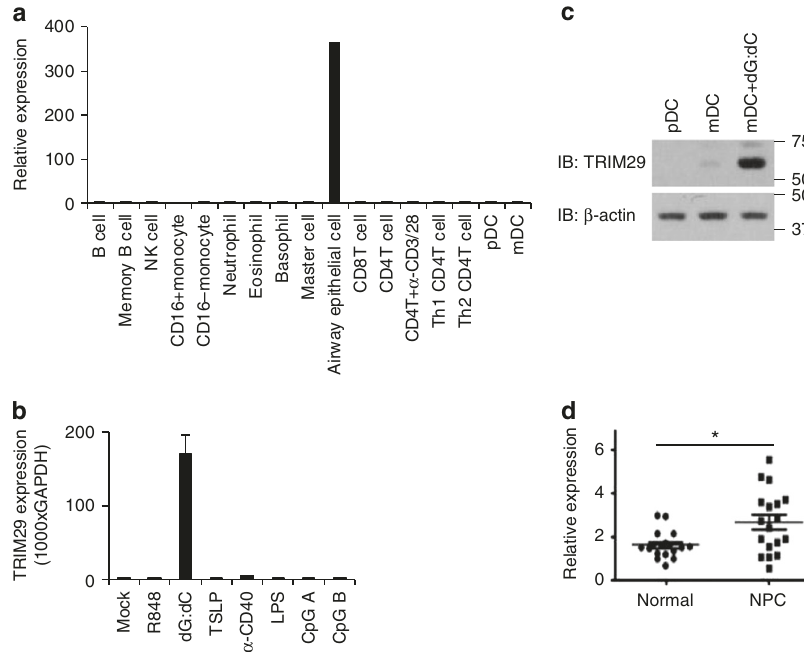
Fig. 1 The expression of TRIM29 in human cells. a , b Human myeloid cells and lymphoid cells were puri fi ed from PBMCs using a cell sorter. Total RNA was isolated from these primary cells and primary airway epithelial cells induced or not a to chip hybridization and microarray, or b to real-time PCR. The pro fi le of TRIM29 expression in different cells is indicated. The relative expression of TRIM29 was compared by plotting the values extracted from the gene expression database. A value < 1 indicated the absence of gene expression. c Immunoblot analysis of TRIM29 and β -actin in plasmacytoid dendritic cells (pDCs), mDCs, and mDCs induced with poly(dG:dC) (dG:dC, 2.5 μ g/ml). Data are representative of three independent experiments. d Total RNA was isolated from human healthy nasopharyngeal epithelium tissues (normal) and NPC tissues to chip hybridization and microarray. The relative expression of TRIM29 was compared by plotting the values extracted from the gene expression database. A value < 1 indicated the absence of gene expression. * P < 0.0001 (unpaired t -test; mean and SD of three samples in b . The position of protein markers (shown in kDa) is indicated on the right NATURE COMMUNICATIONS | 8: 945 | DOI: 10.1038/s41467-017-00101-w |